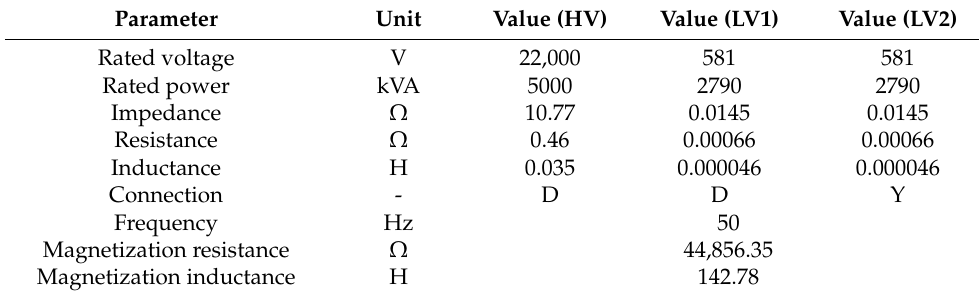
Table 2. Transformer input parameters.